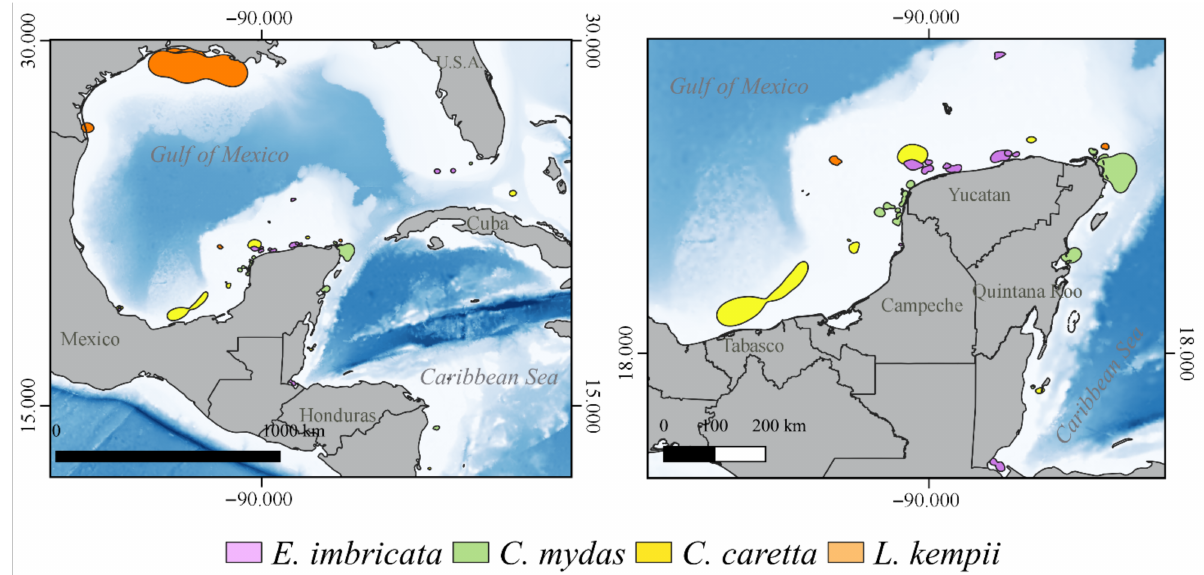
Figure 3. Final feeding and residency habitats of individuals from four sea turtle species satellite-tracked from the Gulf of Mexico and the Western